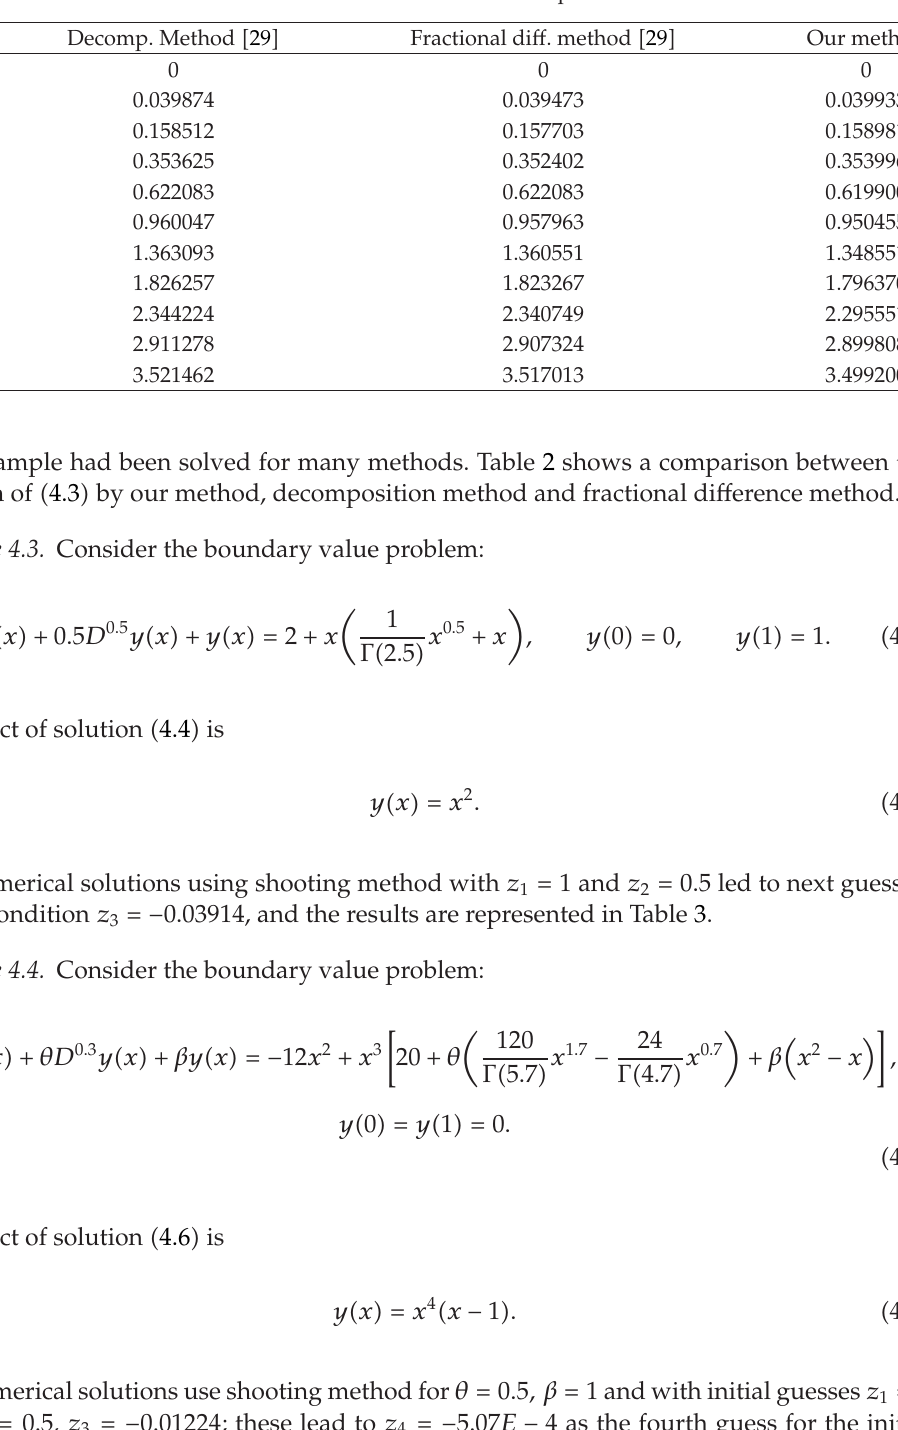
Table 2: Numerical results of Example